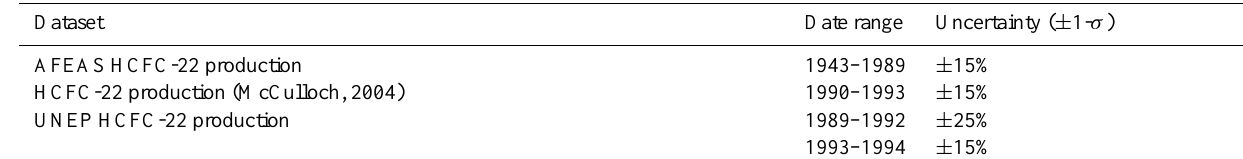
Table 2. Uncertainties of a priori component datasets.